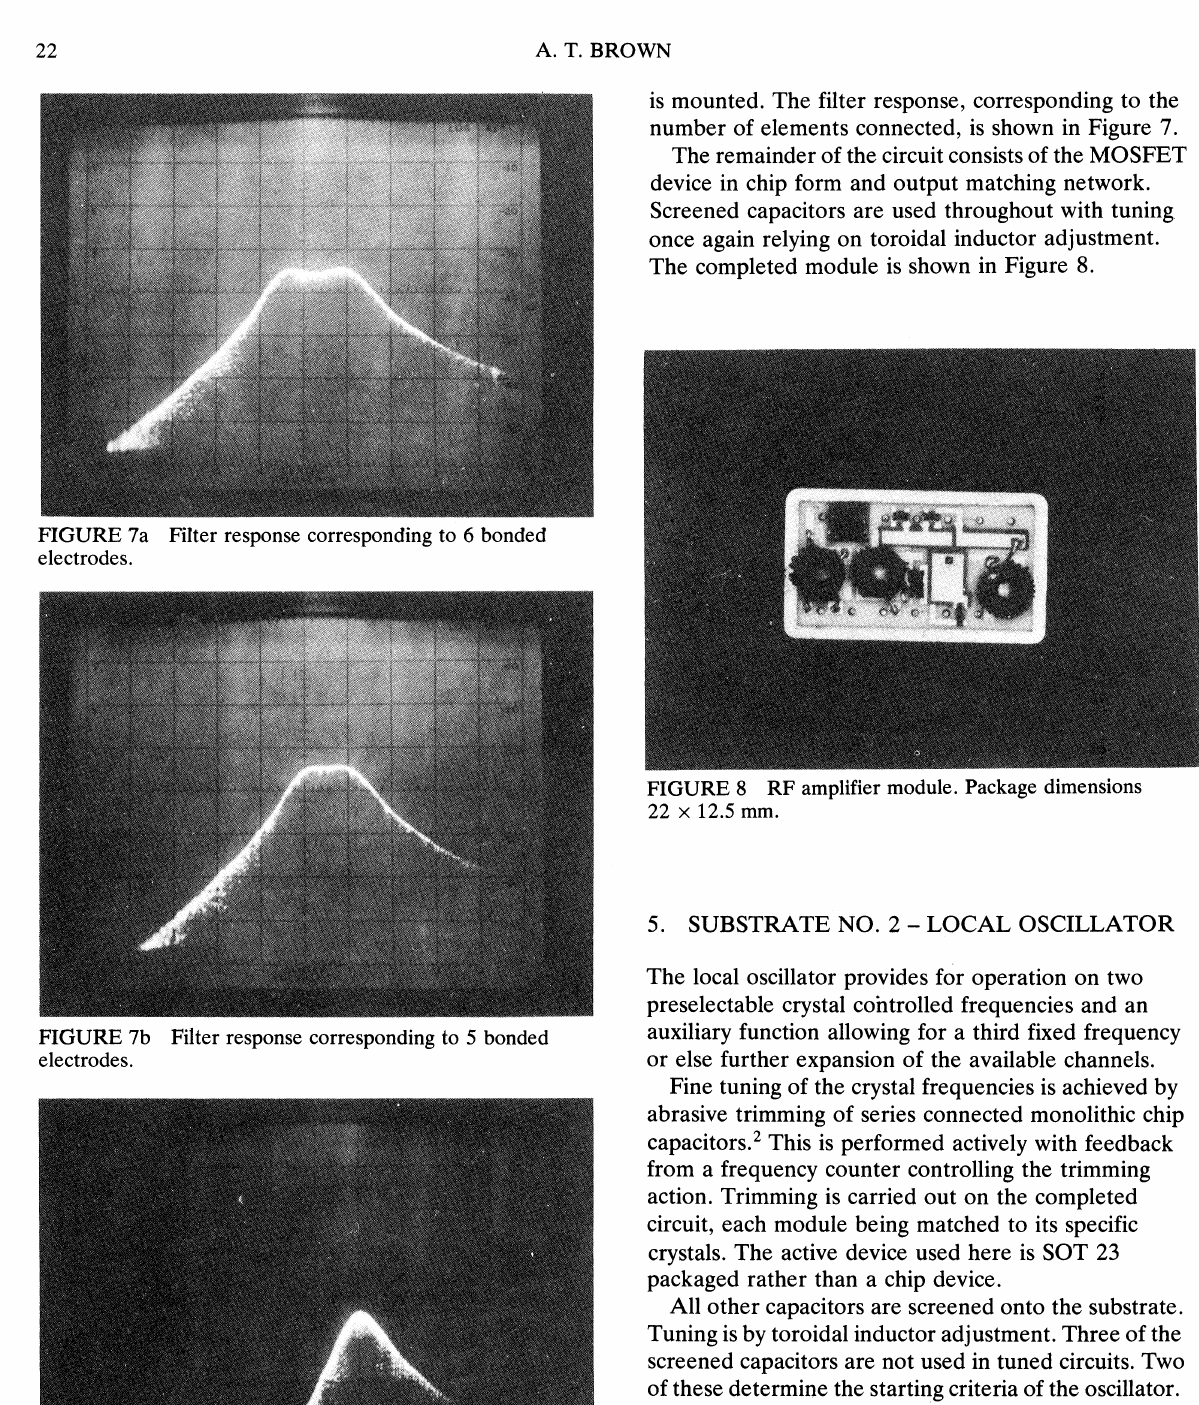
FIGURE 7c Filter response corresponding to bonded